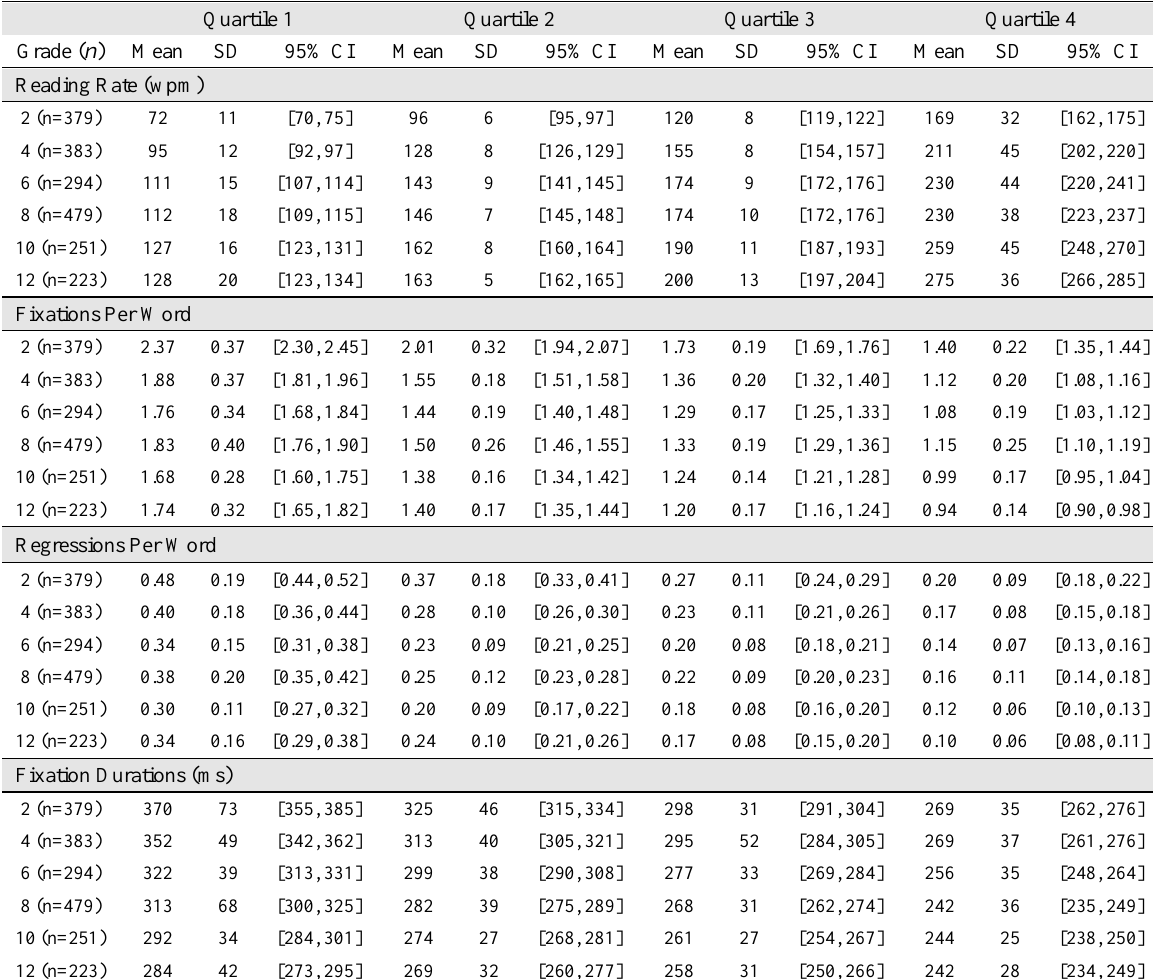
Table 2. Silent Reading Efficiency Measures Across Grades and Quartiles Quartile 1 Quartile 2 Quartile 3 Quartile